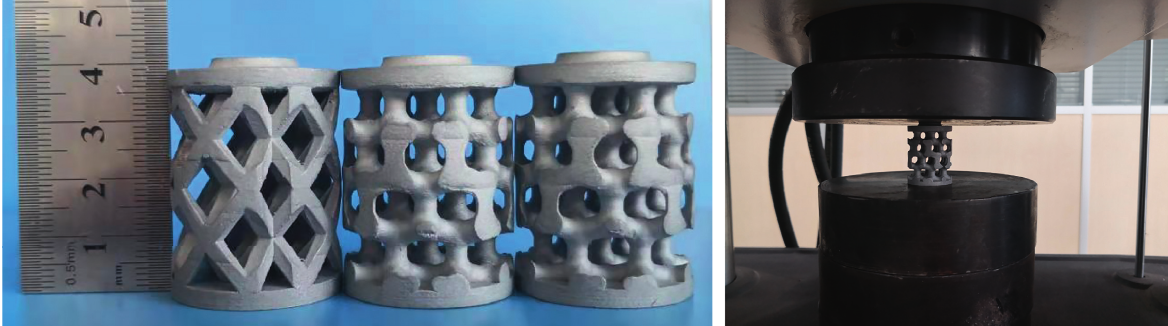
Figure 14: Specimens with AM and their compression test.